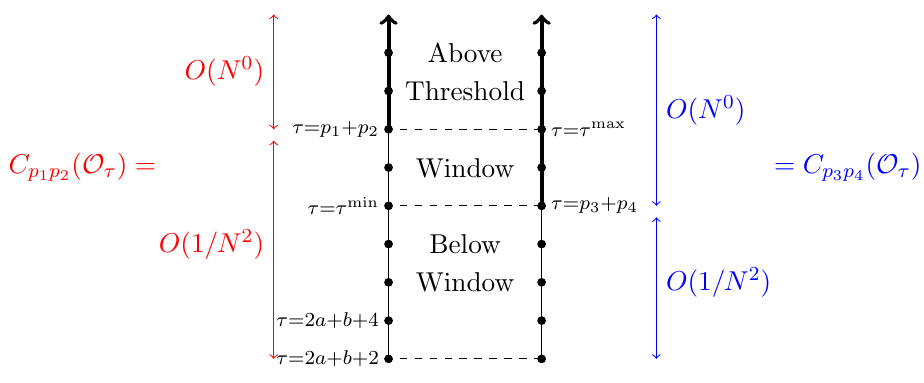
Figure 1 . The large N structure of C p representation [ aba ], and varying